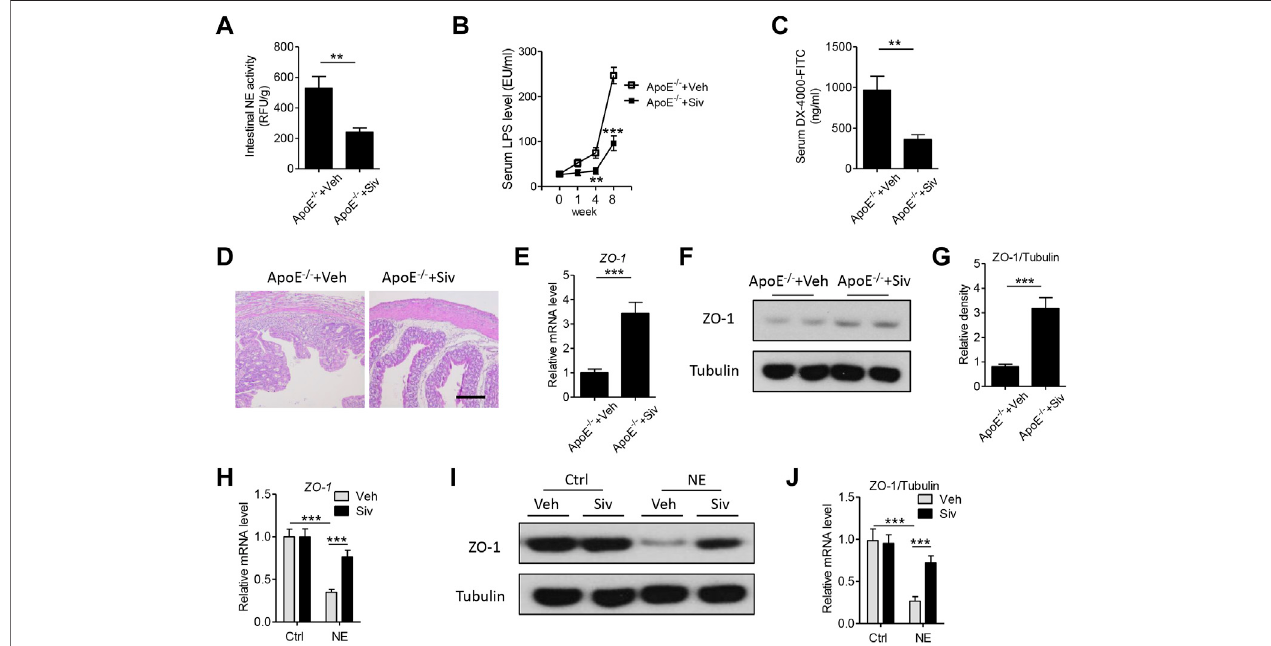
FIGURE 3 | Sivelestat decreases HFHC-induced endotoxemia and intestinal structural disorders by upregulating the intestinal zonula occludens-1 expression in Apo E -/- mice and intestinal epithelial cells. (A – F) Male Apo E -/- mice were fed with HFHC diet for 4 weeks and then treated with sivelestat (Siv, 50 mg/kg per day, intraperitoneal injection) or Veh for 8 weeks. (A) Mouse intestinal NE activity. (B) Measurement of circulating lipopolysaccharide (LPS) levels after sivelestat treatment for 0, 1, 4, and 8 weeks. (C) Mice were orally administered with FITC-labeled dextran, and the circulating concentration of DX-4000-FITC was analyzed. (D) Hematoxylinandeosin(HE)stainingofthecolon.Scalebar=100 μ m. (E) Geneexpression ofintestinalzonulaoccludens(ZO)- 1 . (F – G) Immunoblot analysisofintestinal ZO-1 (F) andquantitativeanalysisoftherelativedensityofZO-1/Tubulin (G) . (H – J) 1 × 10 6 ratintestinalepithelialcellswerepretreatedwithsivelestat(100 μ M)orDMSO and stimulated with 0.1 μ g/ml human neutrophil elastase recombinant protein for 24 h. (H) Real-time PCR analysis of the ZO-1 gene level. (I – J) Immunoblot analysis of ZO-1 protein expression (I) and quantitative analysis of the relative density of ZO-1/Tubulin (J) . Data are shown as mean ± SEM. n = 6 mice/group or n = 5 independent experiments, and ** p < 0.01, *** p <